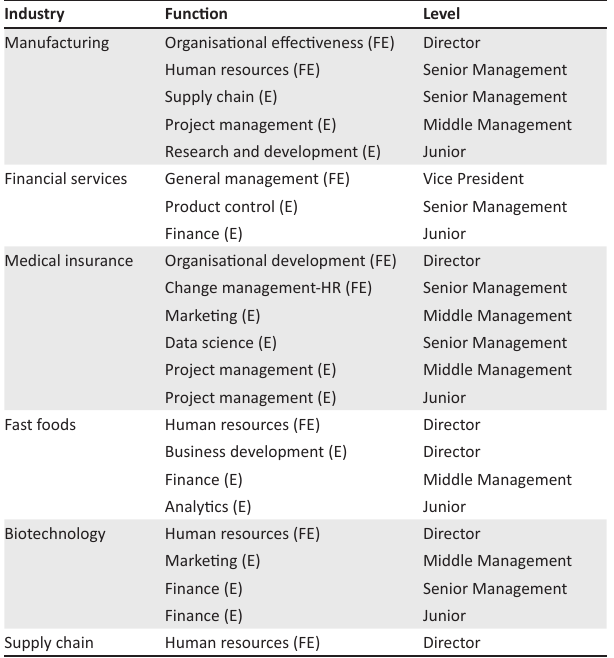
TABLE 1: Industry, function and level of the chosen sample.